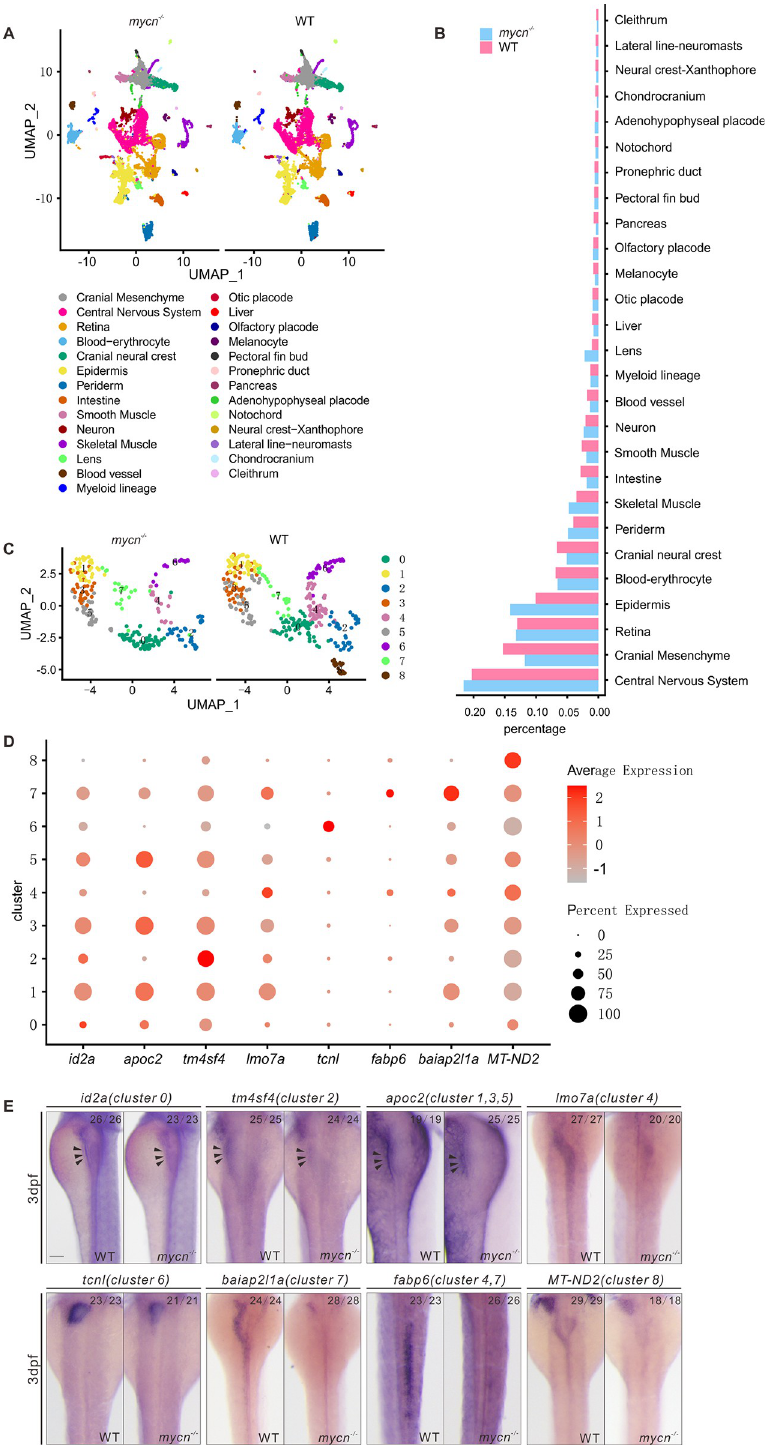
Fig 3. Single-cell RNA-seq analysis of WT and mycn mutant embryos at 3 dpf. (A) Unsupervised clustering of cells in the mycn mutants and WT embryos at 3 dpf. Cells are colored according to their cell type annotations inferred from expressed marker genes and published datasets. (B) Bar plot shows the percentages of each cell type in mycn mutants (blue) or WT embryos (red). (C) UMAP plot shows the subclusters of intestinal cells selected from A. Cells are colored by cell type clusters. A total of 9 clusters were identified by unsupervised clustering. (D) Dot plot shows the